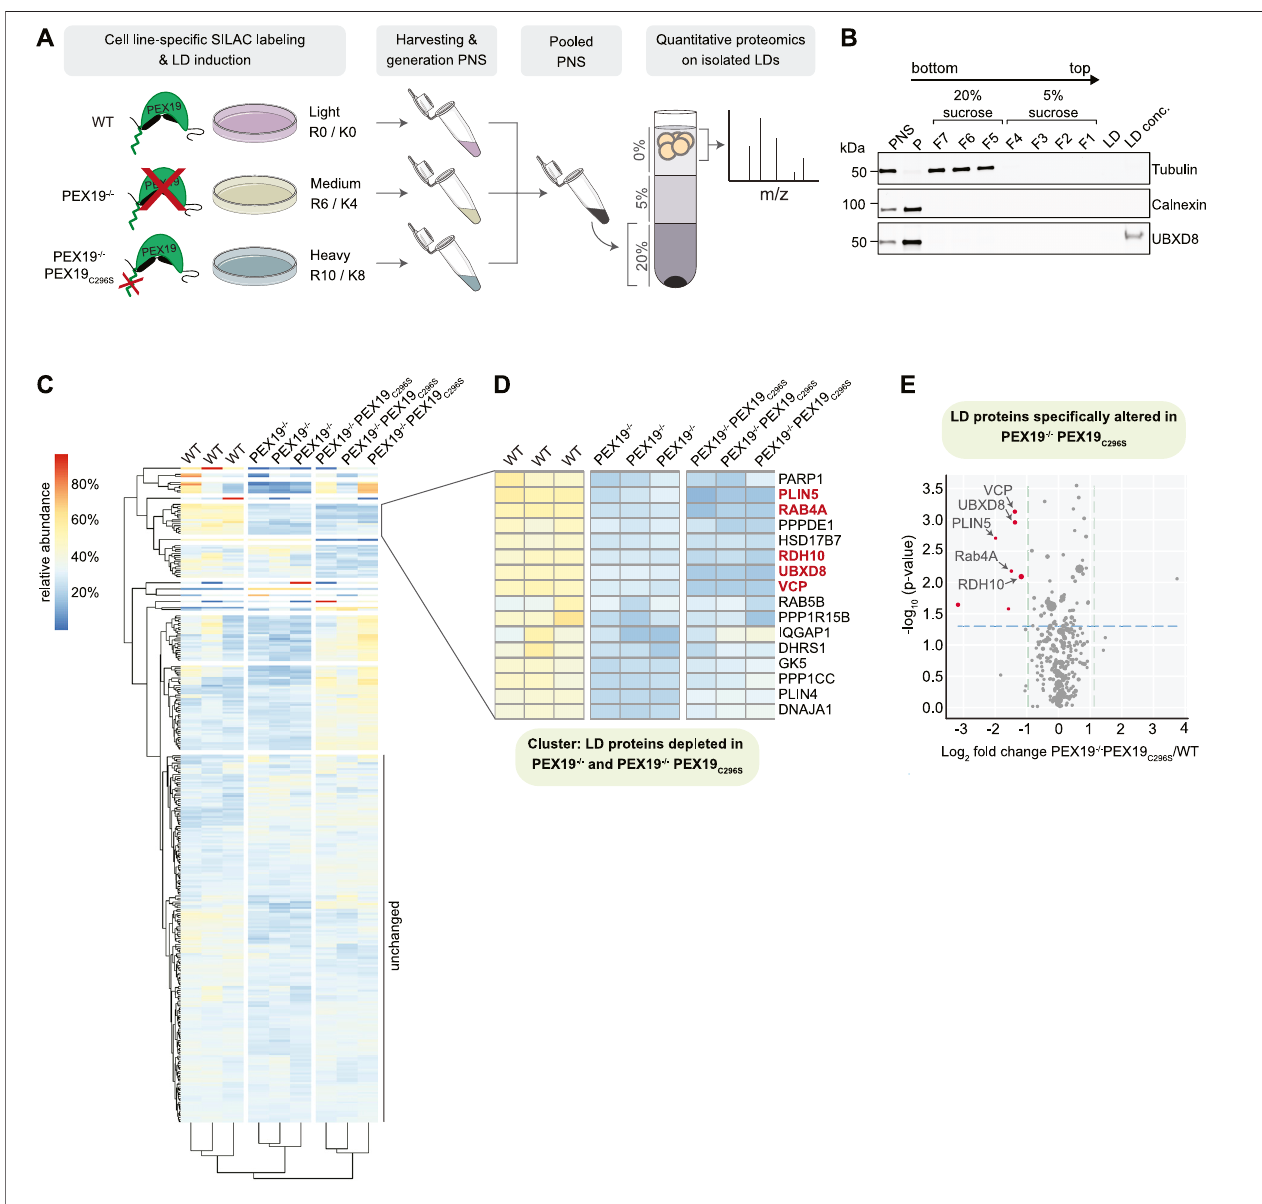
FIGURE 6 | Identi fi cation of PEX19-dependent LD proteins by quantitative mass spectrometry. (A) Schematic outline of stable isotope labeling of wild-type (light: R0/K0), PEX19 − / − (medium: R6/K4) and PEX19 − / − PEX19 C296S (heavy: R10/K8) cells and LD isolation. LDs were isolated from pooled post-nuclear supernatants by density gradient centrifugation. Buoyant LD fractions were further processed for quantitative mass spectrometry. (B) Representative Western Blot analysis of samples taken during the LD puri fi cation procedure from wild-type cells. PNS, post-nuclear supernatant, P, pellet, F7-F5, fractions from step gradient containing 20% sucrose, F4-F1, fractions from step gradient containing 5% sucrose, LD, aliquot from LD fraction, LD conc., proteins in the LD fraction were concentrated by TCA precipitation. Antibodies against tubulin and calnexin de fi ne cytosol-containing and ER-containing fractions, respectively. Anti-UBXD8 antibodies detect endogenous UBXD8 in the PNS input, in the ER-membrane-containing pellet (P) and on LDs. (C) Heat map showing 2-way hierarchical clustering of SILAC-proteomics results for threeindependentexperimentsderivedfromwild-type,PEX19 − / − andPEX19 − / − PEX19 C296S cellsasindicated.Relativeabundancesareindicatedaccordingtothecolor code shown on the upper left. Proteins that are equally abundant on LDs in all three cells lines have a theoretical value of 33.3%. Red color indicates proteins that are relatively enriched, dark blue color indicates proteins that are relatively depleted. (D) Subcluster from heat map in (C) composed of LDproteins that are less abundant in LD fractions derived from PEX19 − / − and PEX19 − / − PEX19 C296S cells compared to wild-type cells. Proteins that are depleted from LDs in PEX19 − / − PEX19 C296S cells compared to wild-type cells with statistical signi fi cance (compare volcano plot in (E) ) are indicated in red. (E) Volcano plot illustrating differences in the LD proteome of PEX19 − / − PEX19 C296S cells compared to wild-type cells. Proteins that are signi fi cantly ( p ≤ 0.05) depleted from LDs in PEX19 − / − PEX19 C296S cells are indicated by red dotswhereasthedotdiameterre fl ectsoverallabundanceofrespectivepeptidesidenti fi edinthepooledSILACsample.95%con fi denceintervalsareindicatedbyvertical green-dotted lines. Horizontal, blue-dotted line indicates a p -value of 0.05.